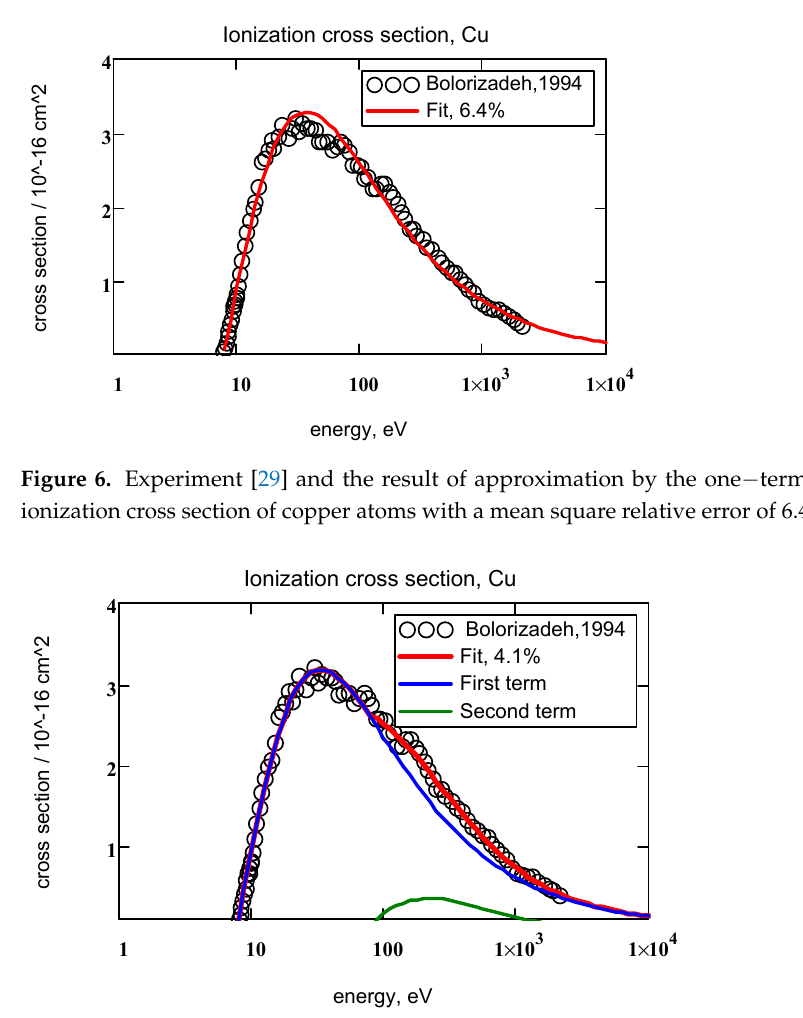
Figure 7. Experiment [29] and the result of approximation by the two − term Formula (7) of the ionization cross section of copper atoms with a mean square relative error of 4.1%.